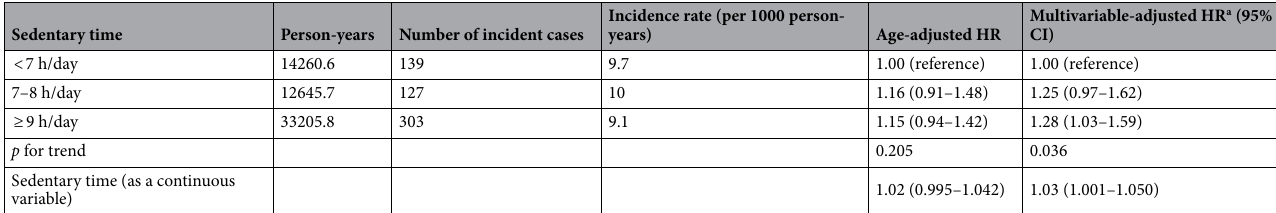
Table 2. Development of positive coronary artery calcium score (CACS) by sedentary time in study participants. CI confidence interval, HR hazard ratio. a Adjusted for age, alcohol intake, smoking status, regular exercise, BMI, systolic blood pressure, glucose, LDL, triglycerides, medication for dyslipidemia, and hsCRP level.